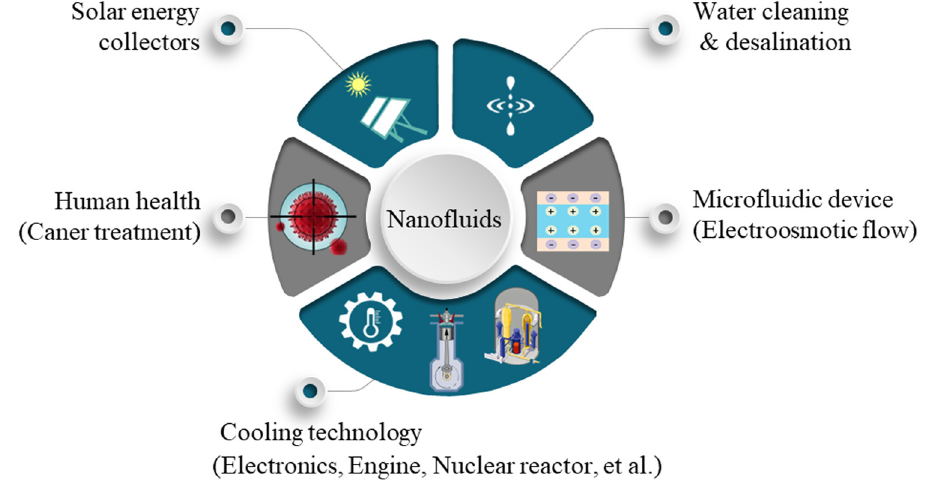
Figure 3: Applications of nano fl